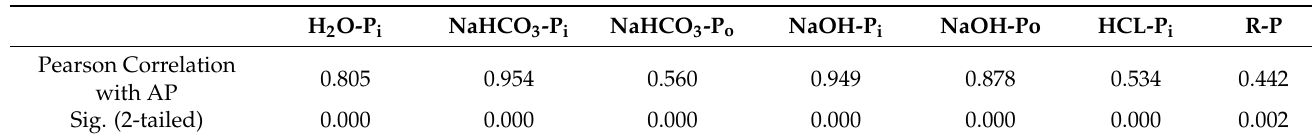
Table 3. Correlation between available phosphorus and various forms of phosphorus in Hed- ley classification.